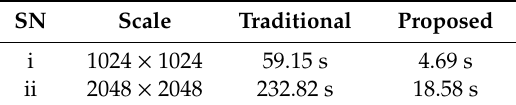
Table 4. Computational burden.